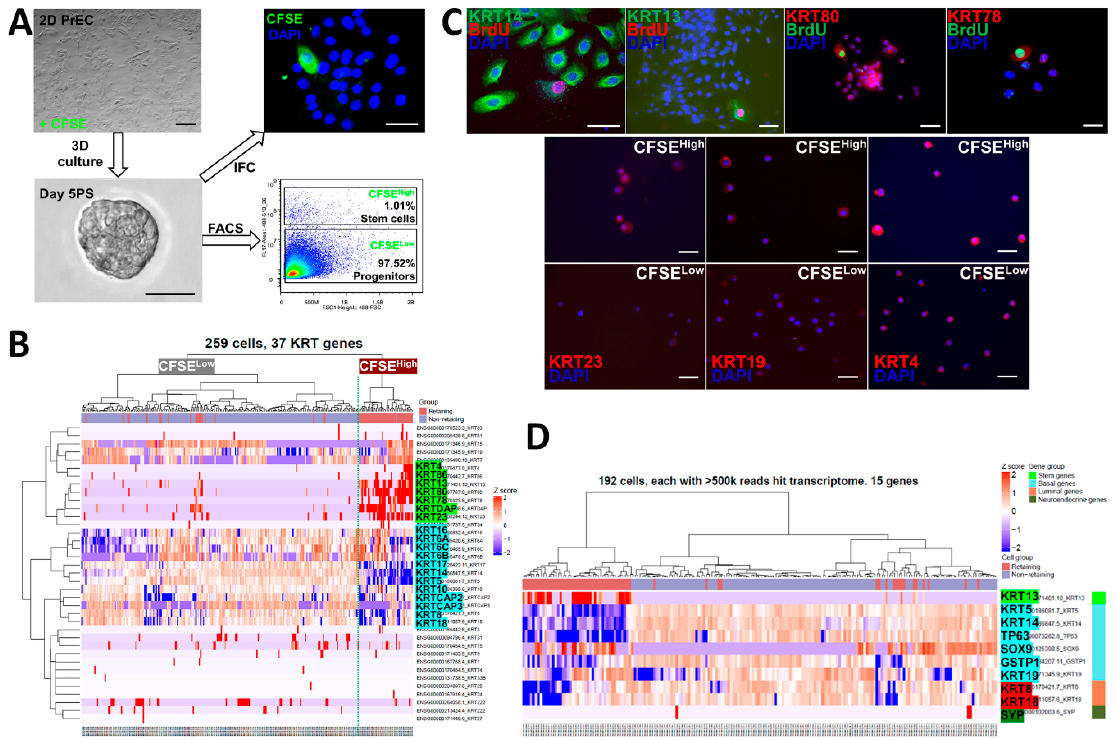
Figure 1. Two groups of differentially expressed keratin genes in CFSE High vs. CFSE Low day 5 prostasphere cells. ( A ) Normal primary prostate epithelial cells (PrEC) pre-labeled with CFSE were 3D cultured (5 days) to form prosta- spheres (PS), followed by FACS to separate CFSE High stem-like cells (1.01%) from CFSE Low progenitor cells (97.52%). Scale bar = 50 µ m. ( B ) Heatmap clustering of Fluidigm C1 captured single-cell RNA-seq of prostasphere cells revealed en- richment of KRT13, 23, 80, 78, 86, and 4 in CFSE High prostate stem-like cells (89 cells), while KRT6, 17, 14, 5, 8, and 18 were enriched in CFSE Low progenitor cells (170 cells). ( C ) Top, Immunostaining confirmed the colocalization of keratins 13, 80, and 78 in BrdU label retaining prostasphere cells (pink) and keratin 14 localization in non-labeled progenitor cells. Bottom, FACS isolated CFSE High prostate stem-like cells immunostained for keratin 23, 19, while CFSE Low progenitor cells did not. Scale bar = 50 µ m. ( D ) Single-cell RNA-seq of CFSE labeled prostaspheres followed by heatmap clustering using selected genes for stem, basal, luminal, and neuroendocrine cells showed enrichment of stem cell marker gene KRT13 in CFSE High prostate stem cells, while basal marker genes KRT5 , KRT14 , TP63 , GSTP1 , and KRT19 , luminal genes KRT8/18 , and neuroendocrine gene SYP were enriched in CFSE Low prostate progenitor cells. SOX9 was uniquely enriched in CFSE High cells and a subpopulation of CFSE Low